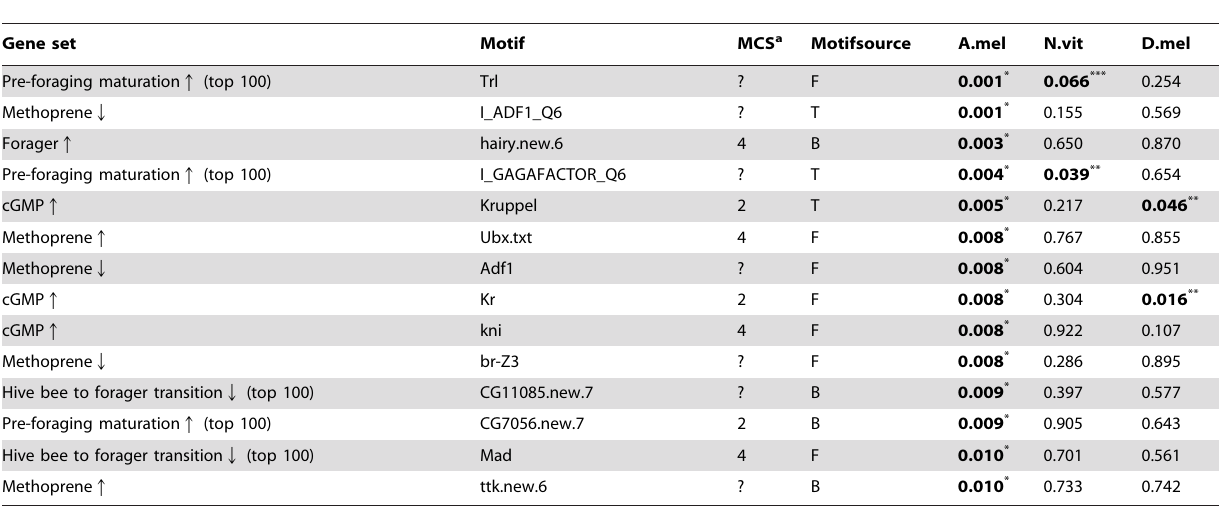
Table 1. Motif associations with gene sets implicated in social behavior in